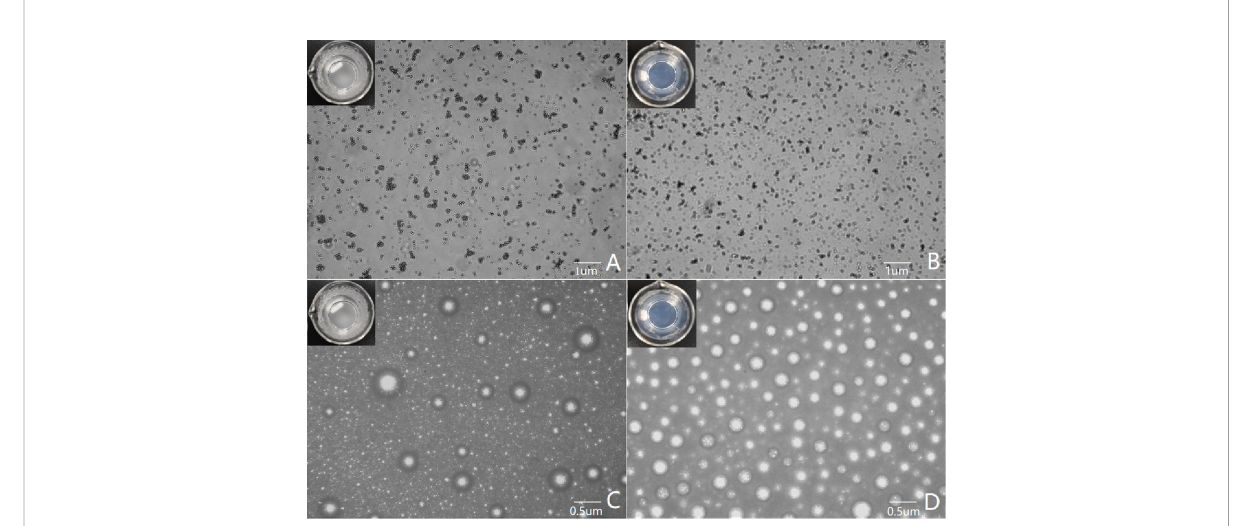
FIGURE 3 Microscopic images of the contrast of poorly imaged and well-imaged UCAs. (A, C) show poor imaging contrast agents, with the lipid suspension in the container appearing cloudy to the naked eye. (A) shows that the lipid particles are aggregated under the microscope, and (C) shows that the bubbles of the contrast agent are different in size and distributed unevenly after encapsulation. (B, D) show good imaging contrast agents, and the lipid suspension in the container is clear and transparent to the naked eye. (B) shows that the lipid particles are evenly distributed under the microscope, and (D) shows that the bubble size distribution of the contrast agent is uniform after